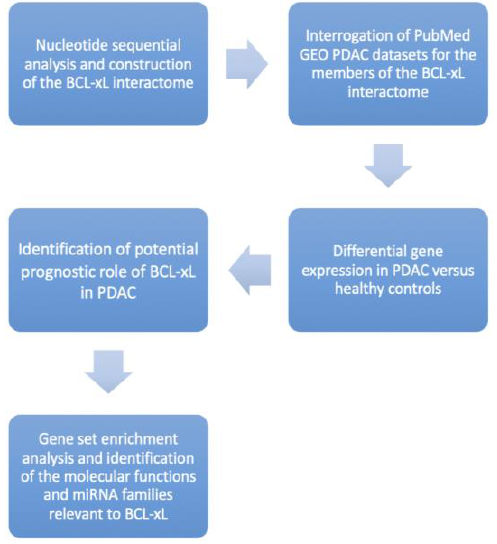
Figure 1. Study Trial Flow demonstrating our research protocol Figure 1 . Study Trial Flow demonstrating our research protocol step-by-step.